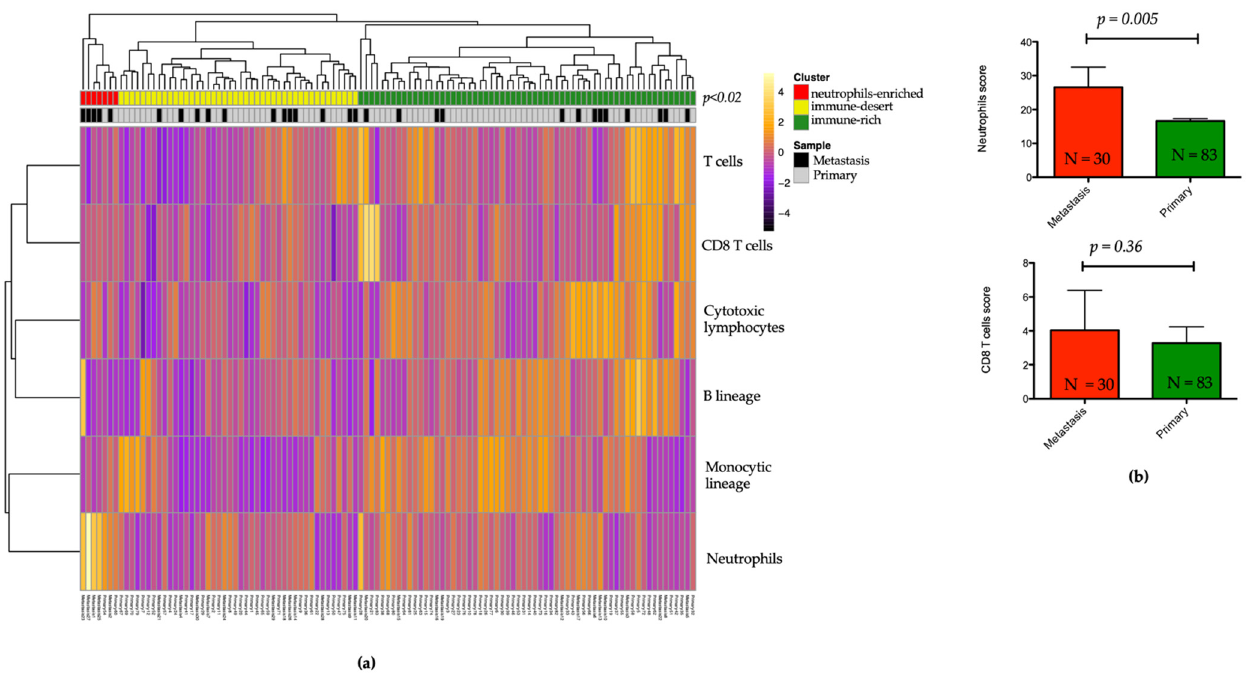
Figure 3. MCP-counter analysis of 113 pancreatic neuroendocrine tumors and distribution of immune cell scores in metastatic and primary tumors. ( a ) Heatmap showing unsupervised hierarchical clustering of immune cells in three clusters. ( b ) Box plot of neutrophils and CD8 lymphocytes score in liver metastasis versus primary pNET tumors.